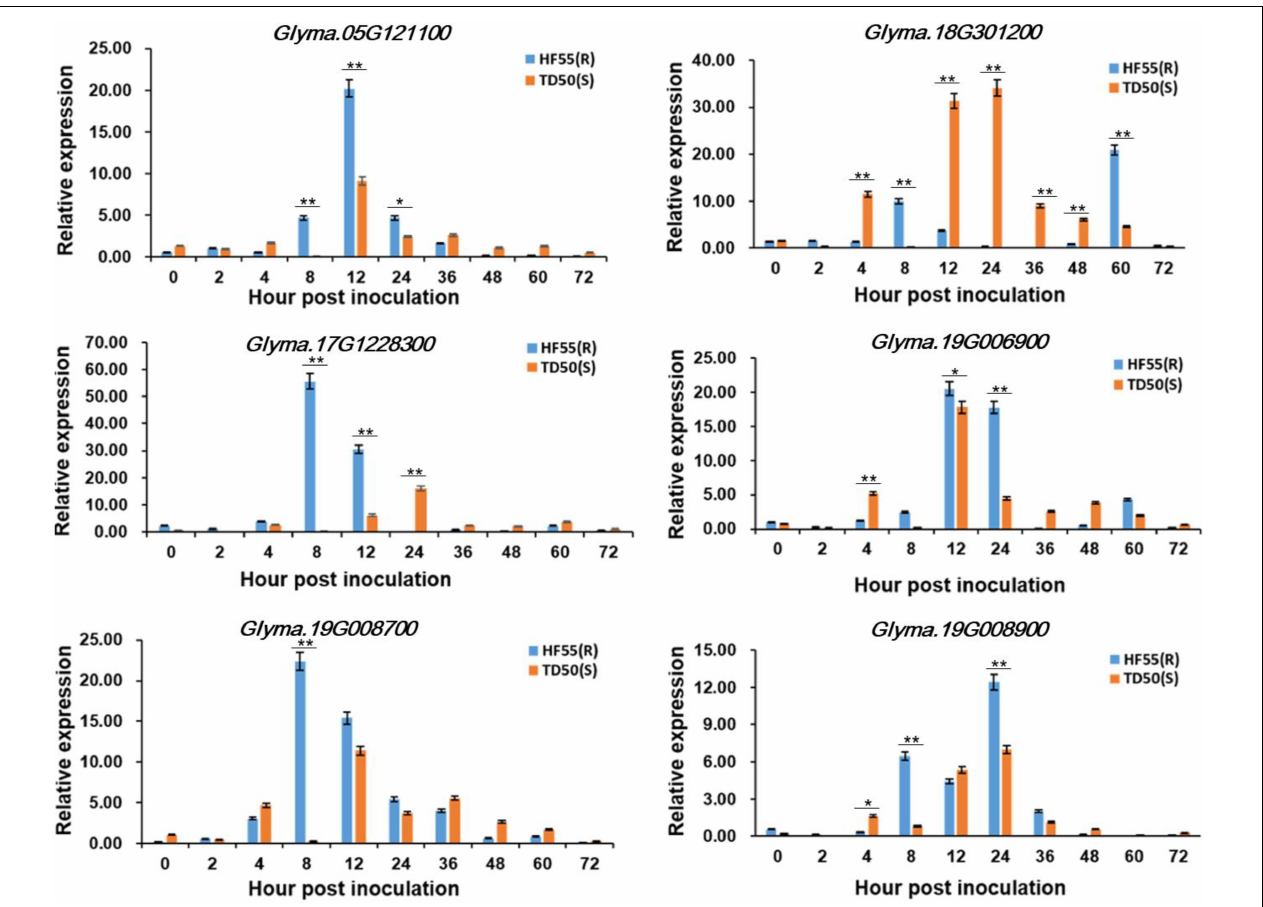
FIGURE 3 | Expression patterns of the candidate genes. The mRNA levels of each candidate gene were analyzed in resistant soybean accession ‘HF55’ and susceptible soybean accession ‘TD50.’ The values were the mean ± SD of three biological replicates. ** and * represented the significance at p < 0.01 and p < 0.05,